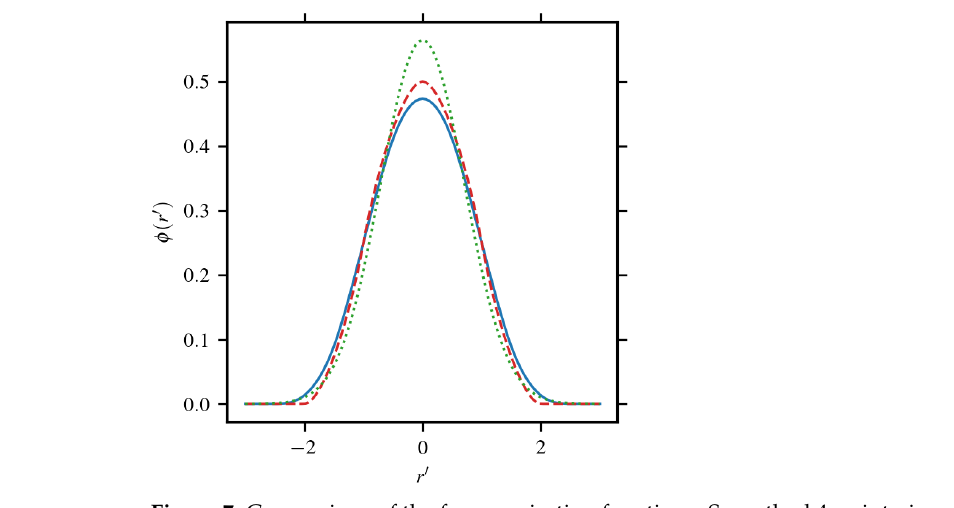
Figure 7. Comparison of the force projection functions: Smoothed 4-point piecewise discrete delta function (blue solid line), 4-point piecewise discrete delta function (red dashed line), and Gaussian function with ε = 1 (orange dotted